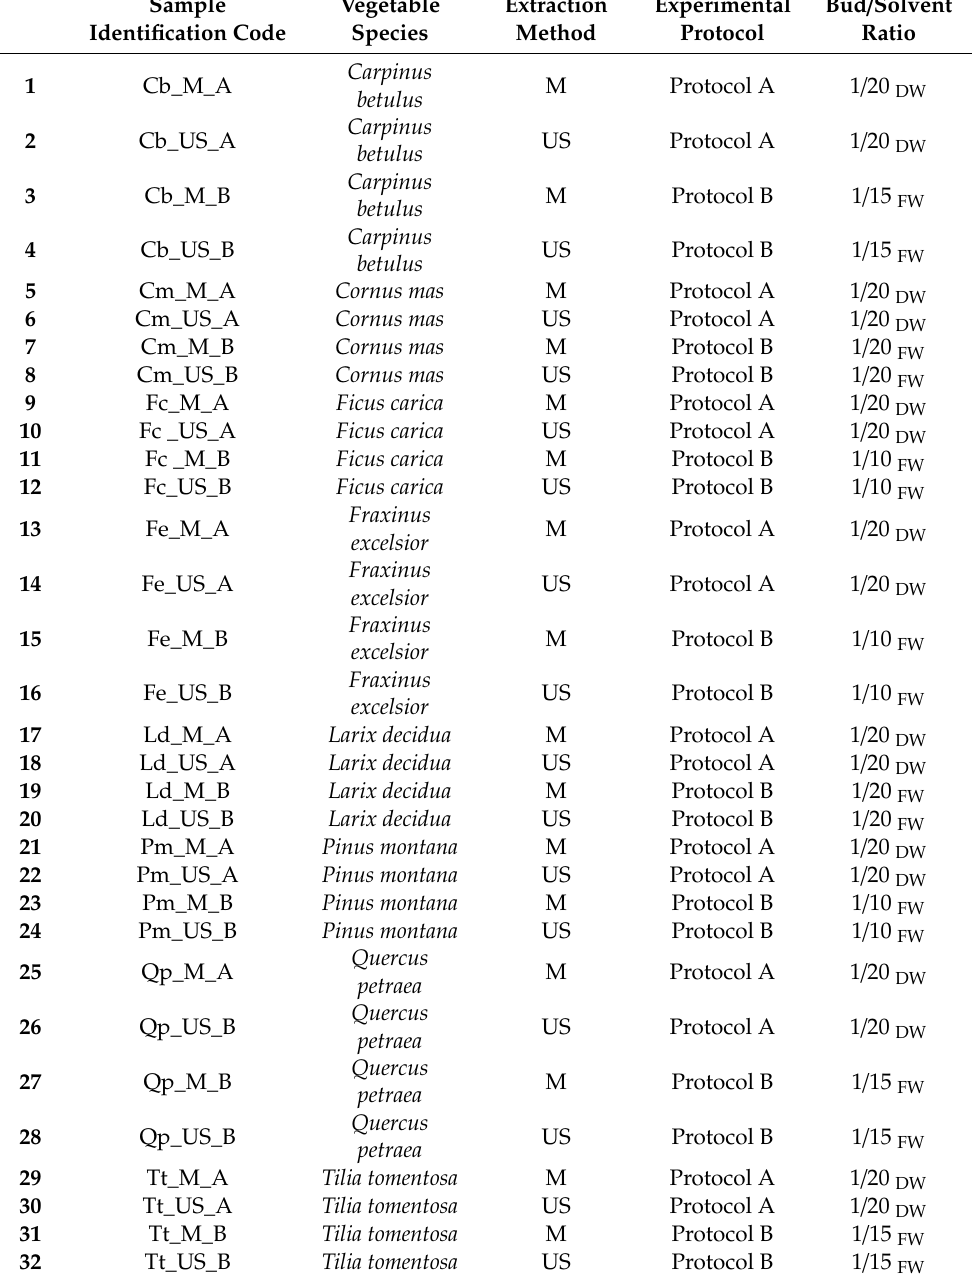
Table 2. BDs obtained starting from the eight vegetable species (raw materials). Two di ff erent methods (cold maceration-M and Pulsed Ultrasound-Assisted Extraction US) and two di ff erent experimental protocol (Protocol A and B) are taken into